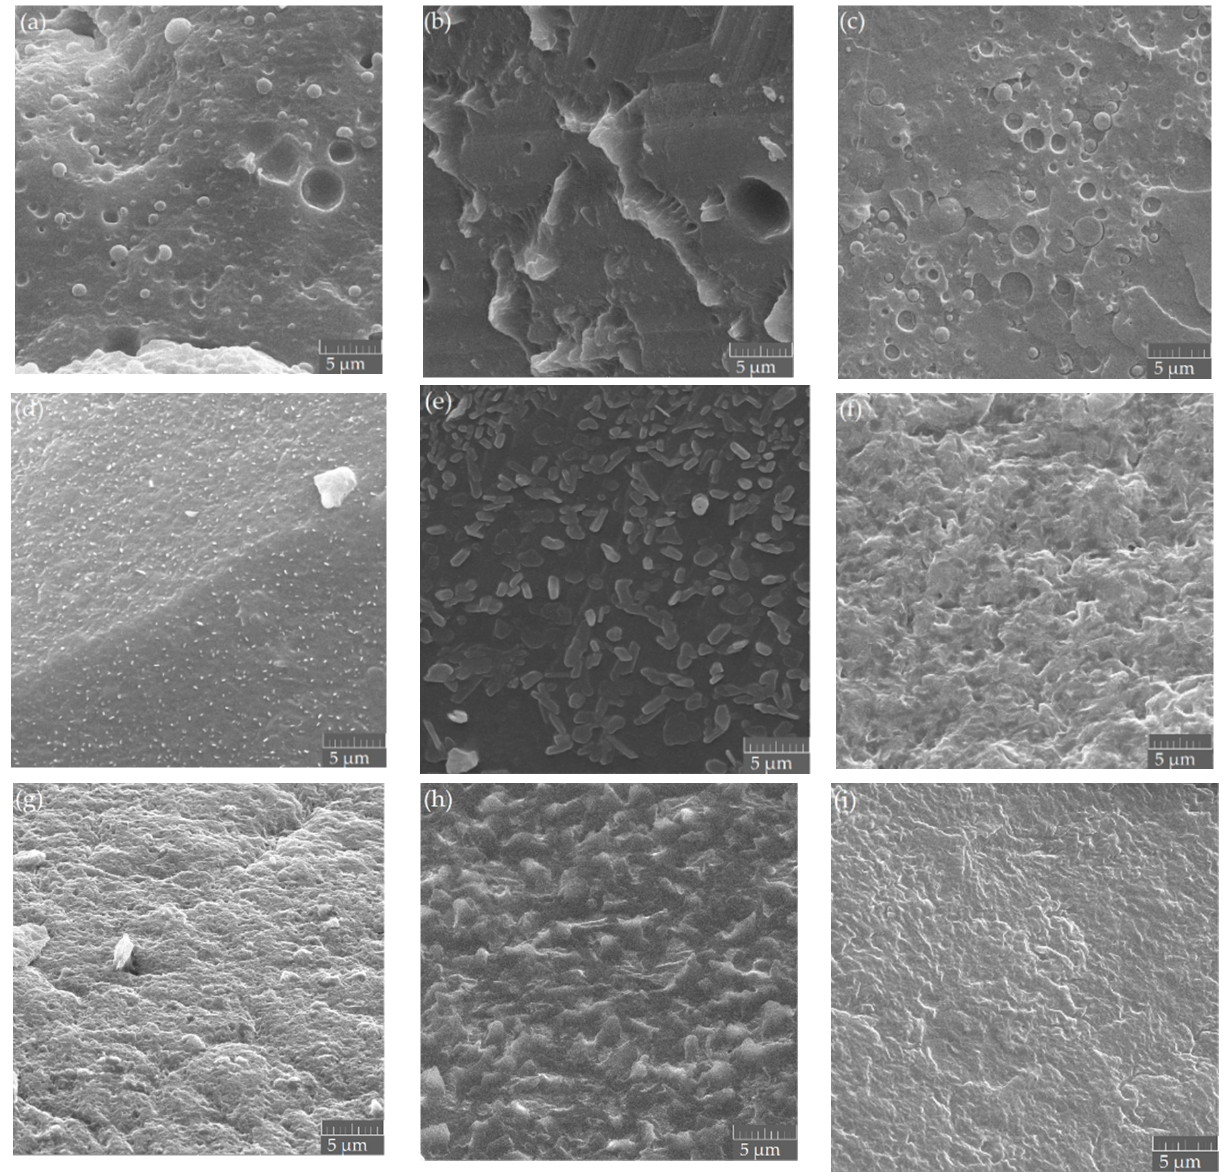
Figure 6. SEM micrographs of cryogenically fractured blend samples: ( a ) B0L0–82, ( b ) B0L0–55, ( c ) B0L0–28, ( d ) B4L10–82, ( e ) B4L10–55, ( f ) B4L0–28, ( g ) B12L12–82, ( h ) B12L12–55, ( i ) B12L12–28.